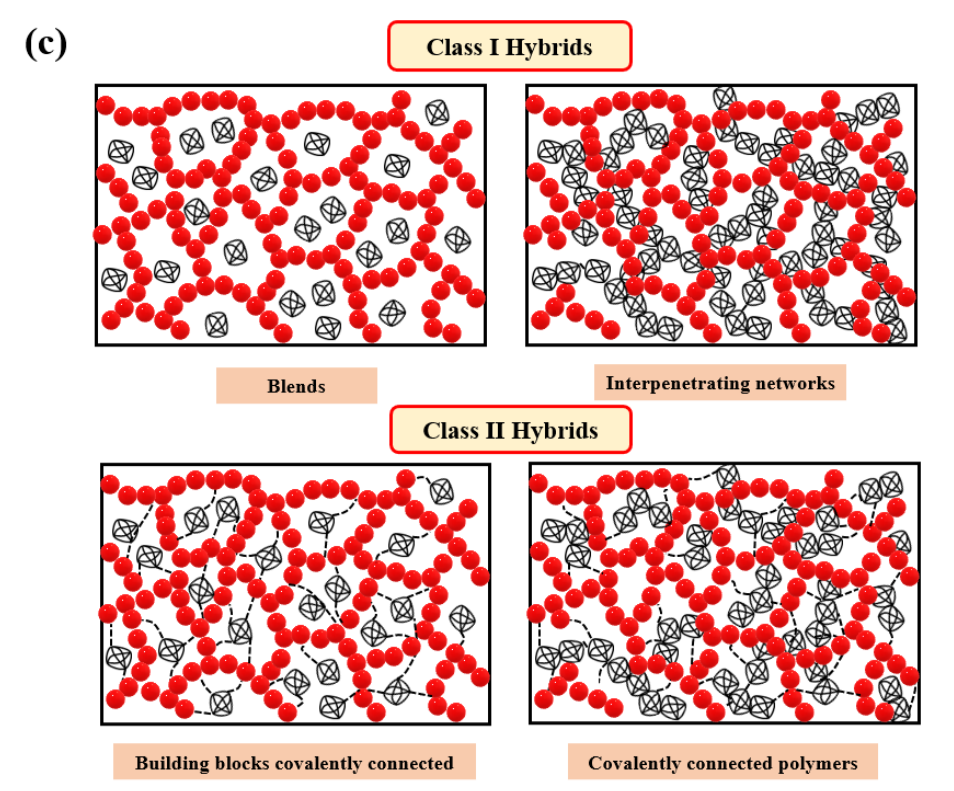
Figure 1. Classification of hybrids: ( a ) general classification [8]; ( b ) several general approaches for the design of sol-gel derived hybrid materials [9]; and ( c ) in terms of bond strength [10].